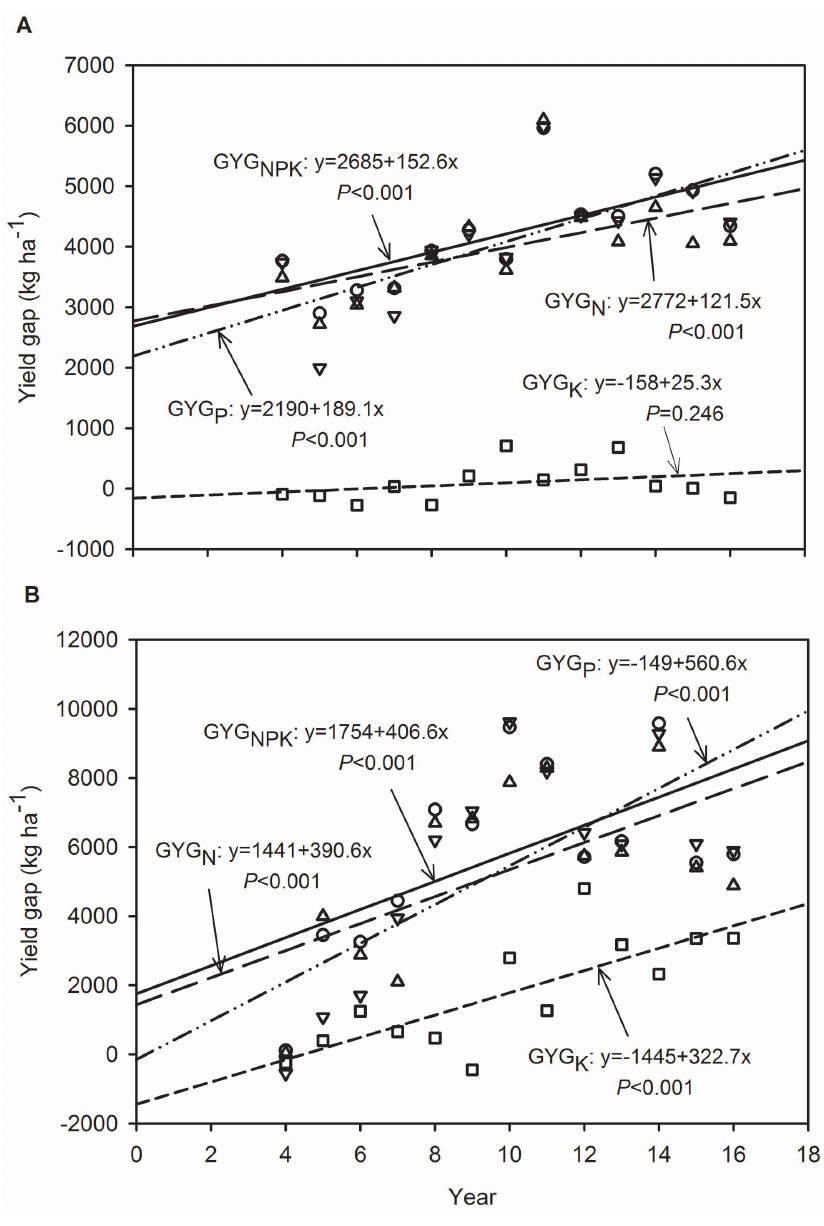
Figure 2. Yield gap variation of wheat (a) and maize (b) by N (GYG N , the yield difference between NPK and PK plots in each year, triangle up), P (GYG P , the difference between NPK and NK plots, triangle down), K (GYG K , the difference between NPK and NP plots, square) or NPK (GYG NPK , the difference between NPK and Control plots, circle) fertilizer omission from 1994 to 2006 at Yucheng, Shandong Province of